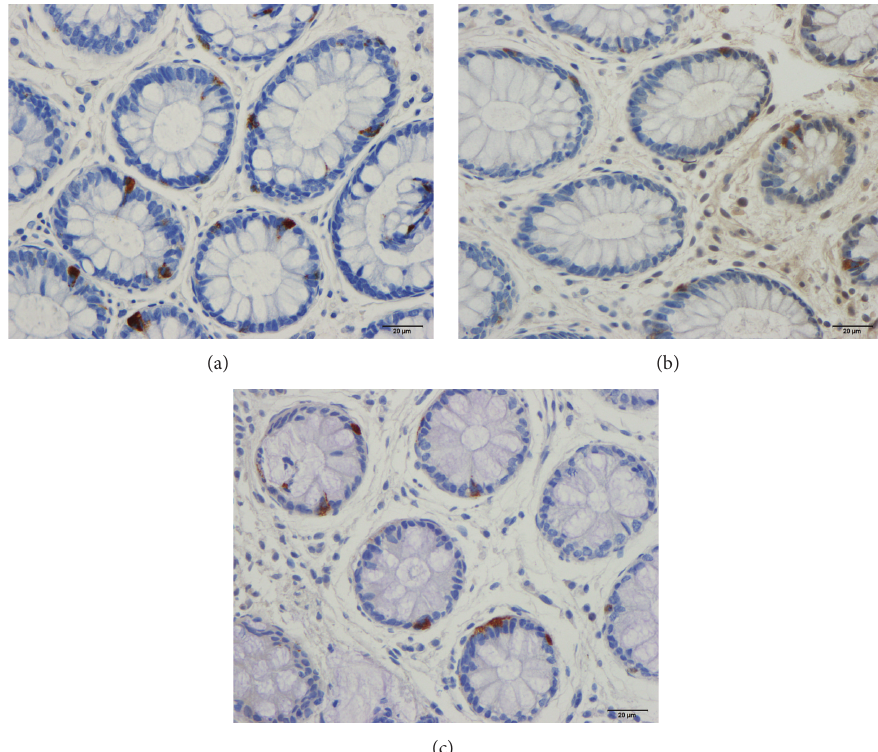
Figure 4: CgA-immunoreactive cells in the rectum of a control subject (a) and of an IBS patient before (b) and after (c) receiving dietary